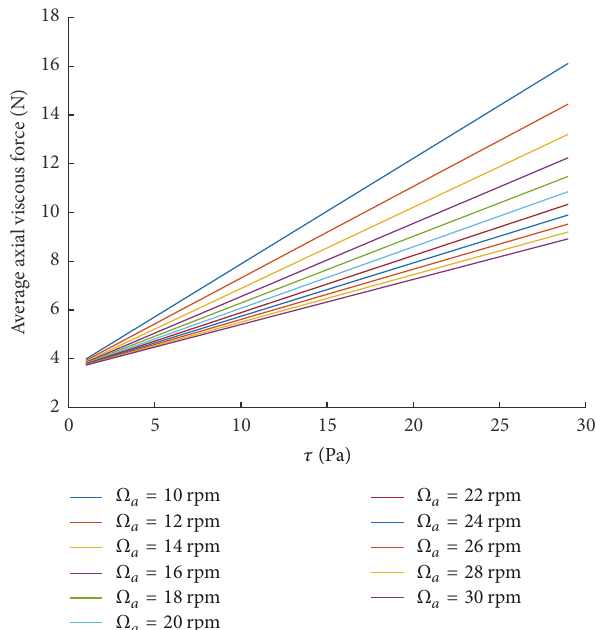
Figure 9: Influence of dynamic shear of drilling mud on the change in axial viscous force.